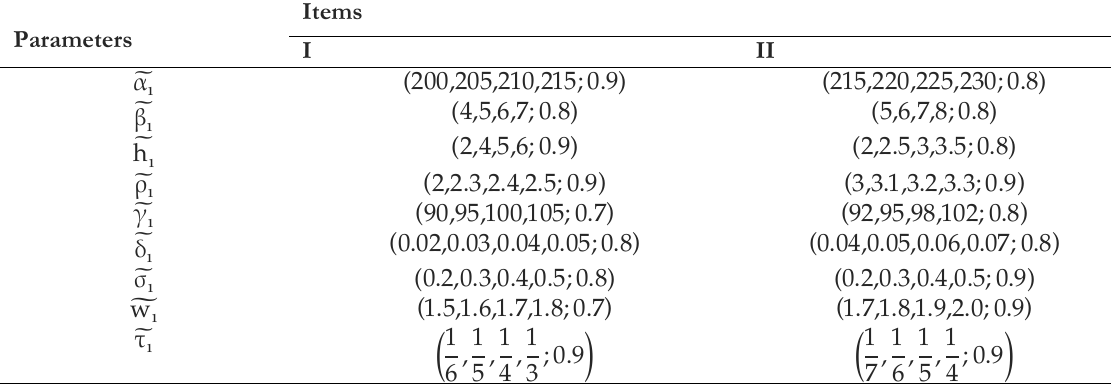
Table 1. Input imprecise data for shape parameters.